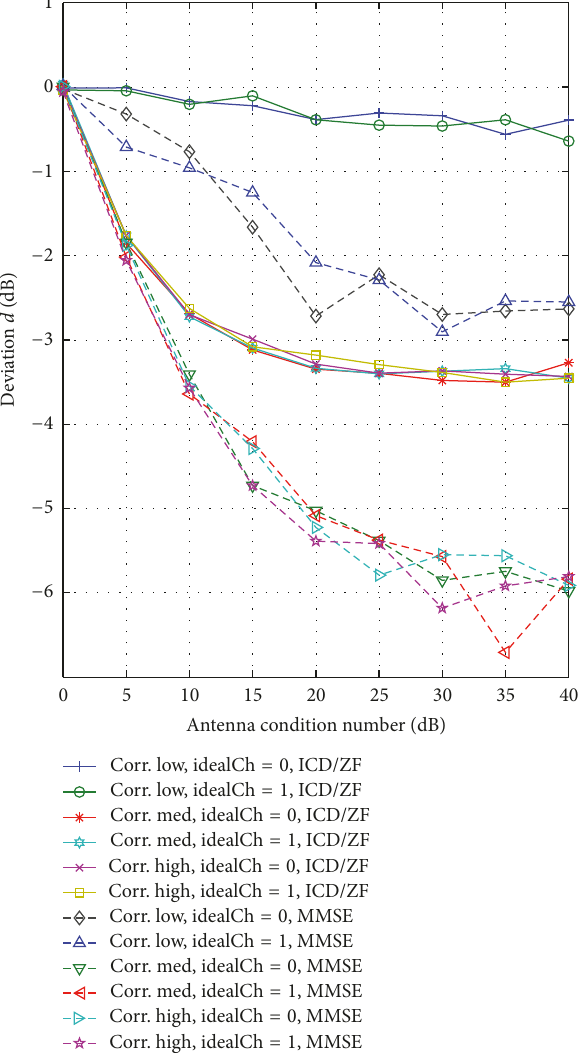
Figure 14: Deviation 𝑑 versus antenna condition number for DLSCH processing on/off, nonideal channel estimation; low, medium,andhighchannelcorrelation;ICD/ZFandMMSEreceiver.